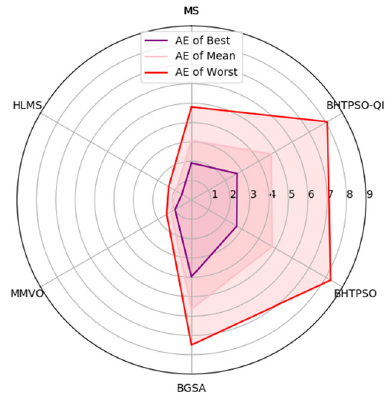
Figure 4. The performance comparison of 6 methods based on AE for Test set III (cb1 – cb3).